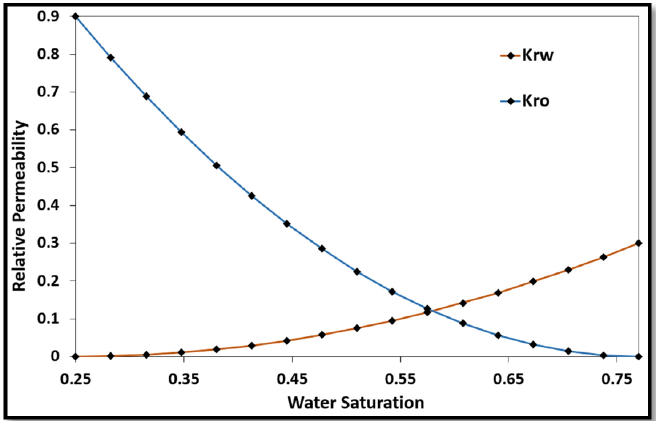
Figure 2. Relative permeability profile at the before the injection of polymer flooding.